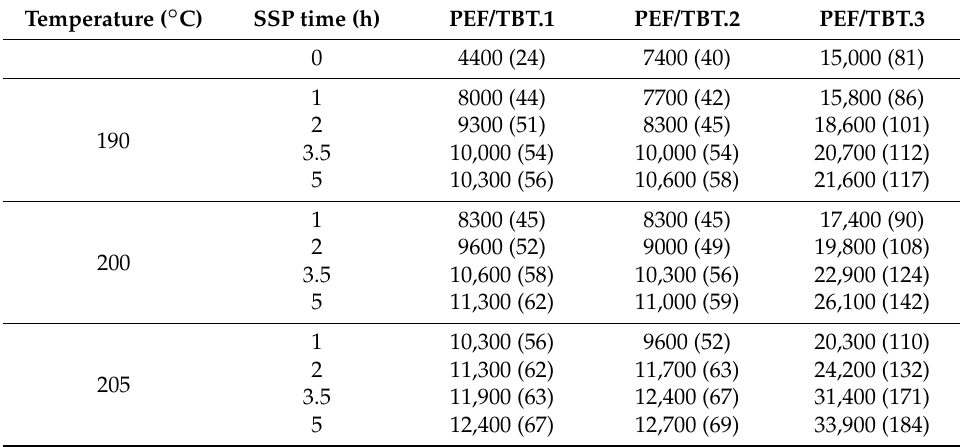
Table 1. Number average molecular weights ( M n , g · mol − 1 ) of PEF polyester using TBT catalyst obtained after SSP at different temperatures and times. The value includes, in parentheses, the corresponding number average degree of